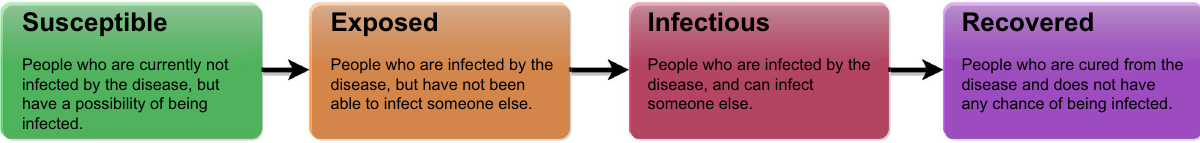
Figure 1. The diagram illustrates the different stages of an SEIR compartmental model. Although it can be observed that the infectious population further approaches to recovered state, a portion of the infectious population may not survive the disease and lose their